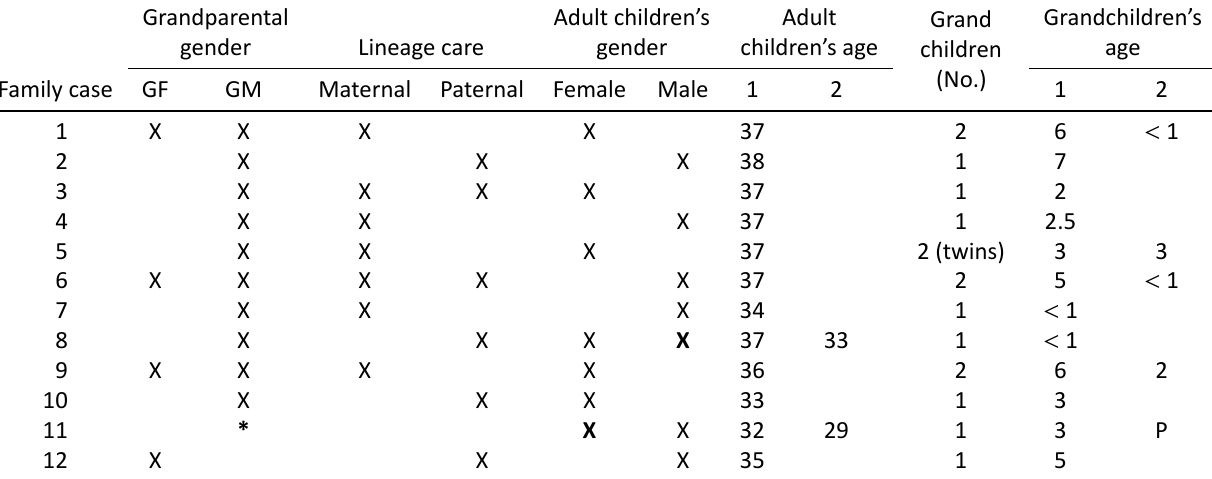
Table 1. Families’ basic